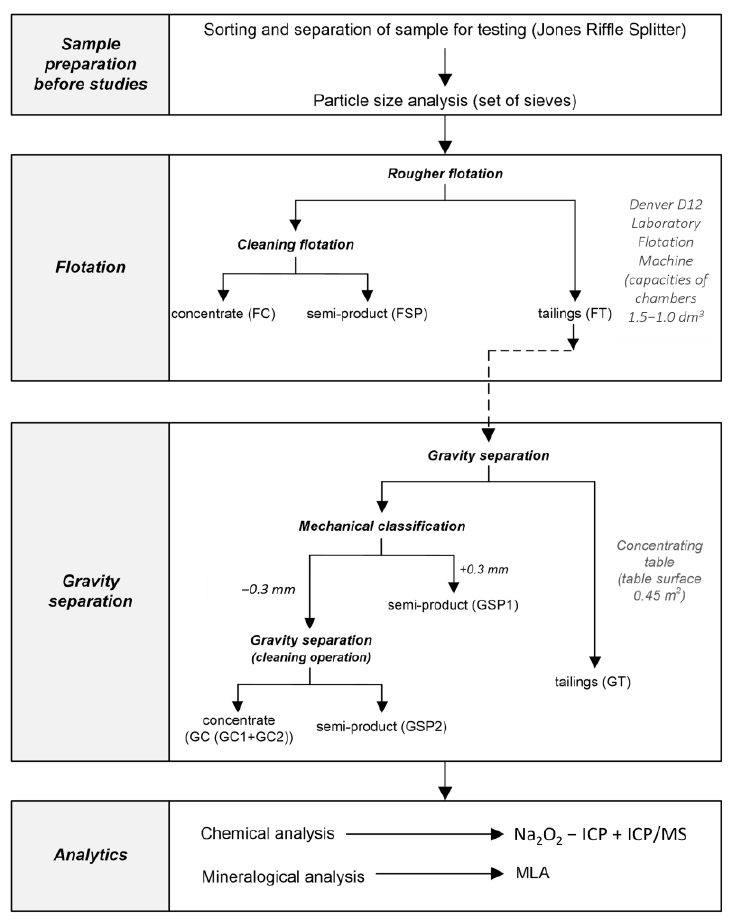
Figure 1. The scheme of research.